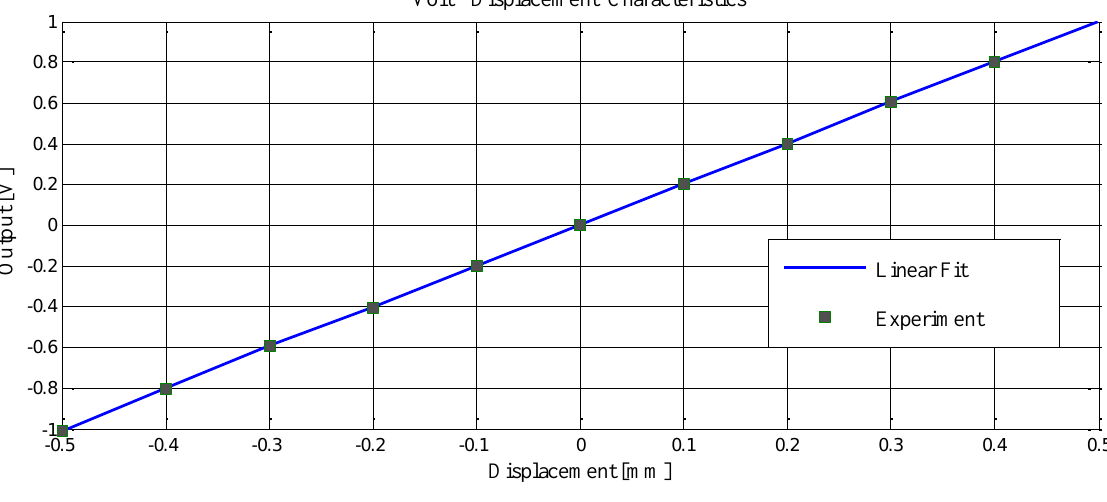
Figure 21. Frequency response of inductive displacement sensor exhibiting notch filter.